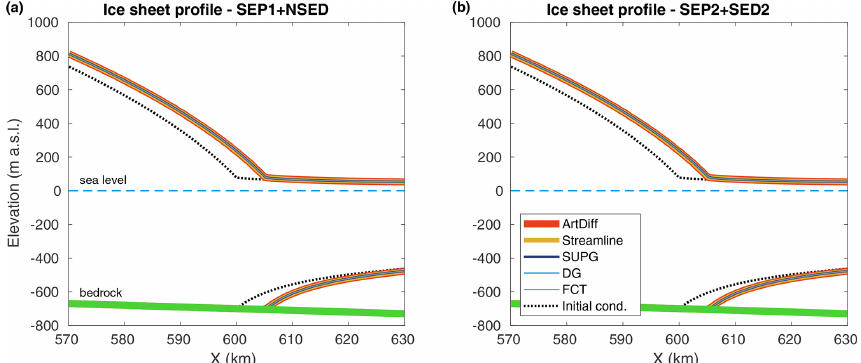
Figure 4. No external forcing experiment: ice surface and ice base at the end of the experiment ( t = 100 years) for different stabilization schemes (see legend). Two sets of parameterizations are employed: SEP1 + NSED (a) and SEP2 + SED2 (b) . The dotted black line is the initial ice-sheet geometry, defined by Eq. (37). Here, the mesh resolution is equal to